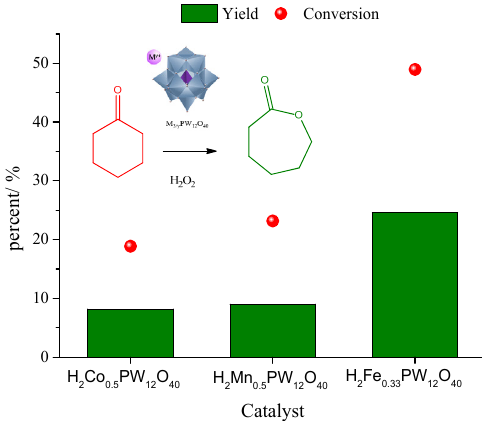
Figure 17. Baeyer Villiger oxidation of cyclohexanone with hydrogen peroxide over partially exchanged-phosphotungstic acid salts (adapted from ref. [12]).